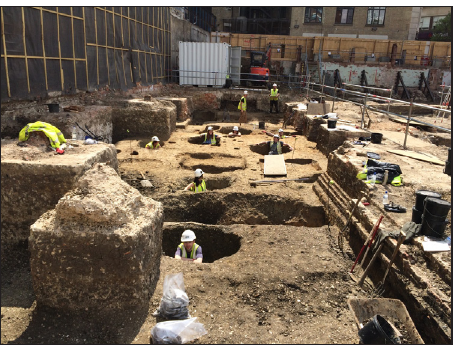
Figure 8: Urban archaeology at the London School of Economics (Photo Sarah